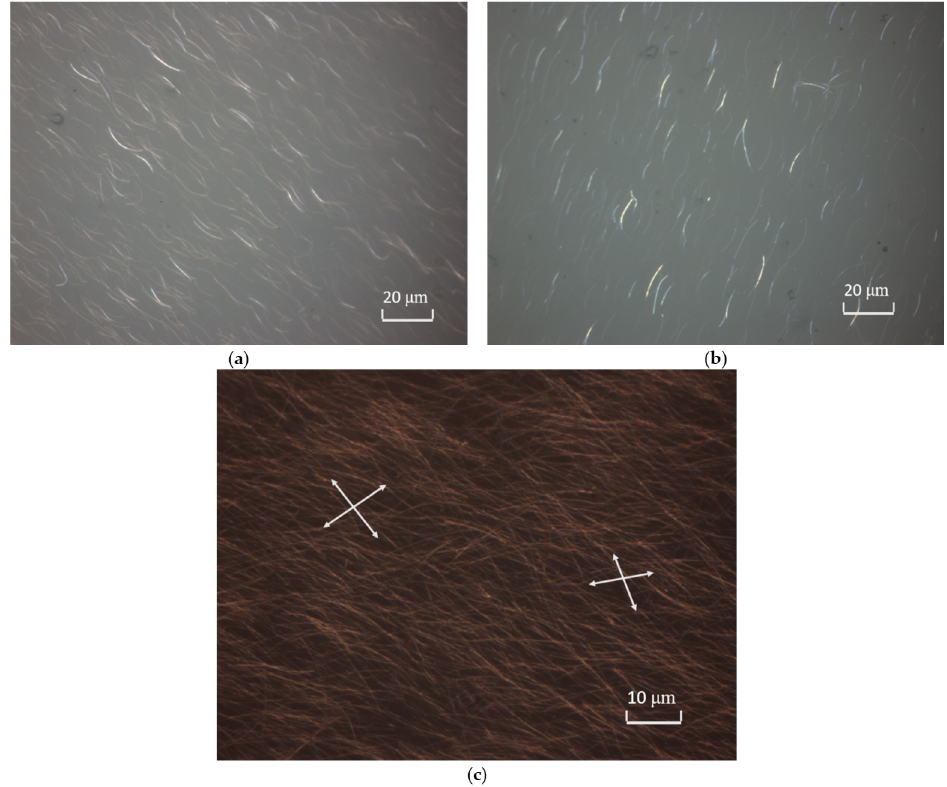
Figure 3. Optical microscope images of single layer and uniaxially aligned AgNW films after amina- tion: ( a ) after ultraviolet irradiation; ( b ) without UV irradiation. ( c ) Optical microscope images of double-cross AgNW transparent conductive film.,arrows indicate the nanowire alignment